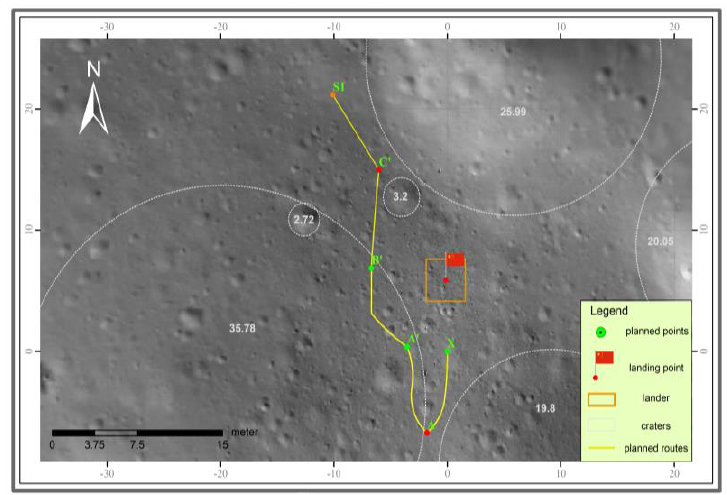
Figure 7. Schematic diagram of periodic planning for rover and lander photographing each other